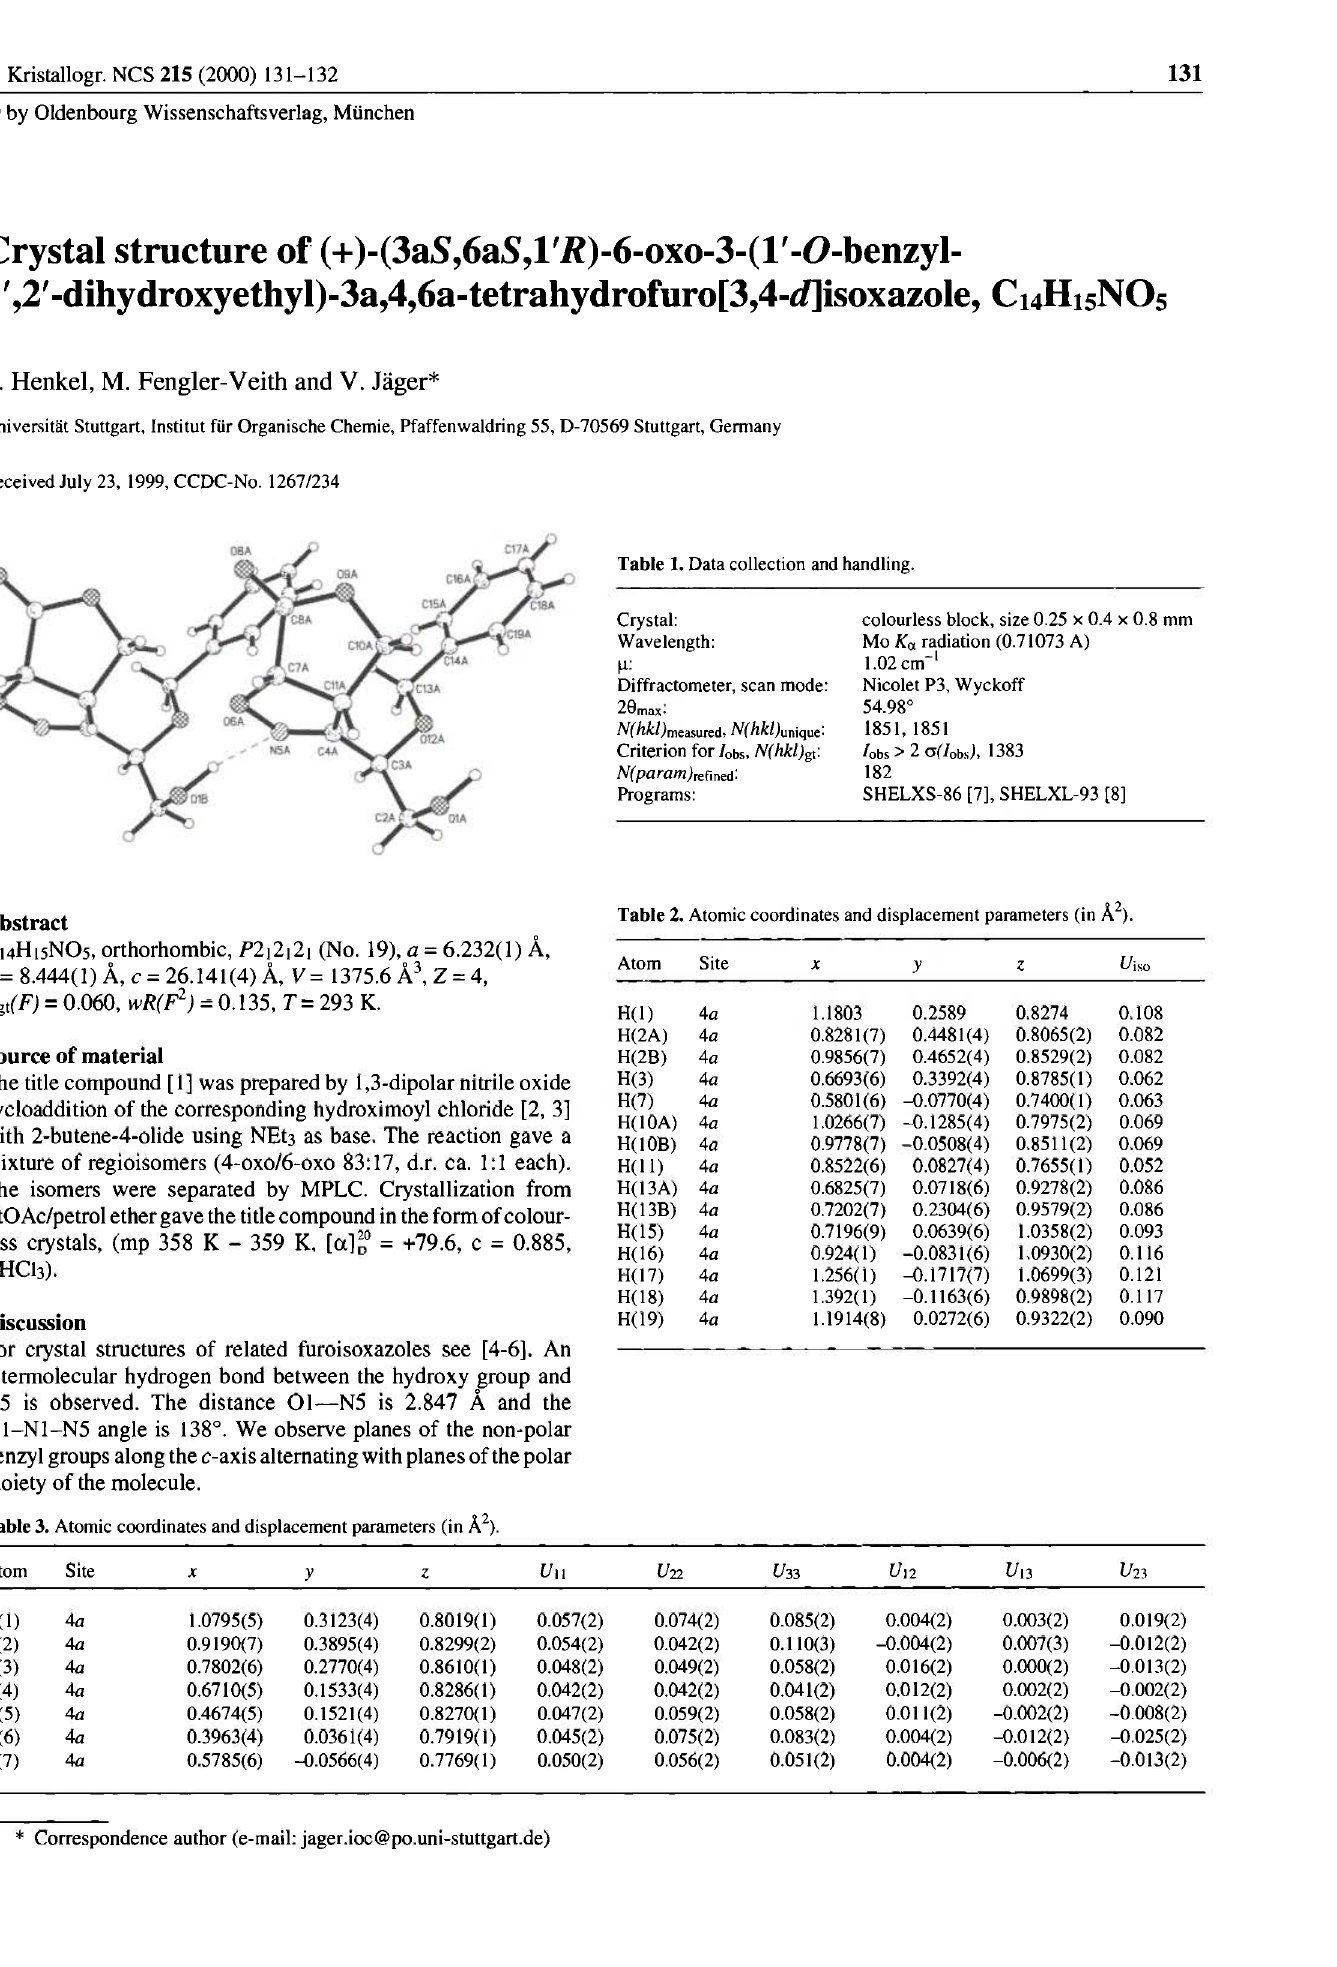
Table 1. Data collection and handling.